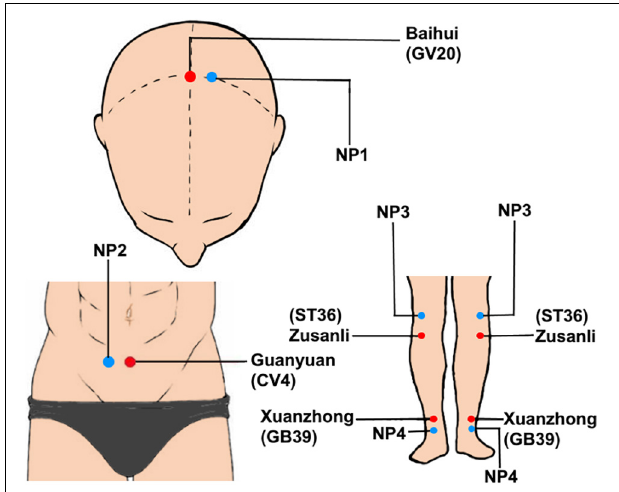
FIGURE 1 | Locations of selected acupoints and non-acupoints. The acupoints were Baihui (GV20), Guan yuan (CV4), bilateral Zusanli (ST36), and Xuanzhong